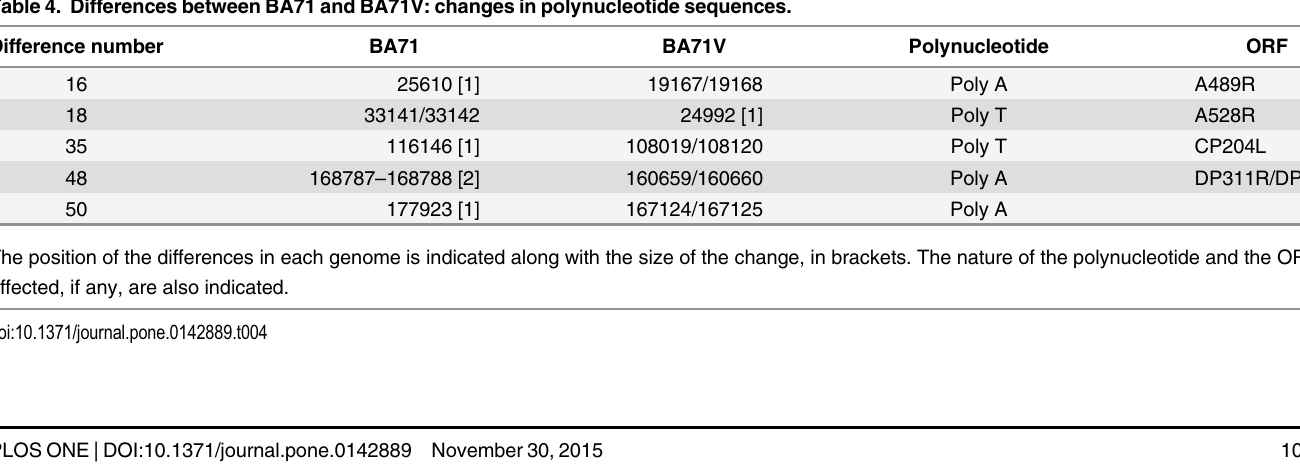
Table 4. Differences between BA71 and BA71V: changes in polynucleotide sequences.